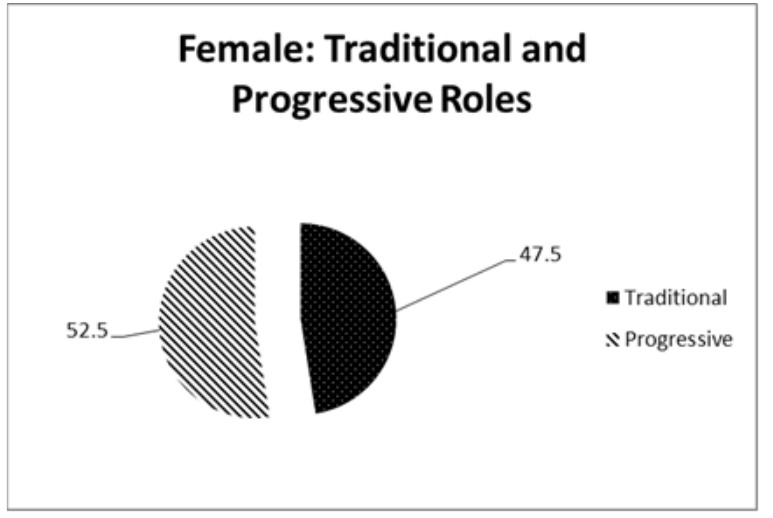
Ratio of traditional versus progressive roles females portray. The representation between traditional and progressive roles is nearly equal for